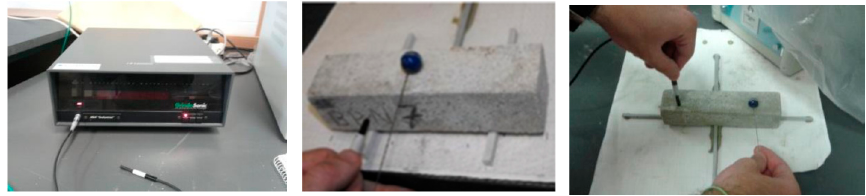
Figure 2. GrindoSonic MK5 equipment (left); test to obtain flexural vibration frequency (center); test to obtain torsional vibration frequency (right).